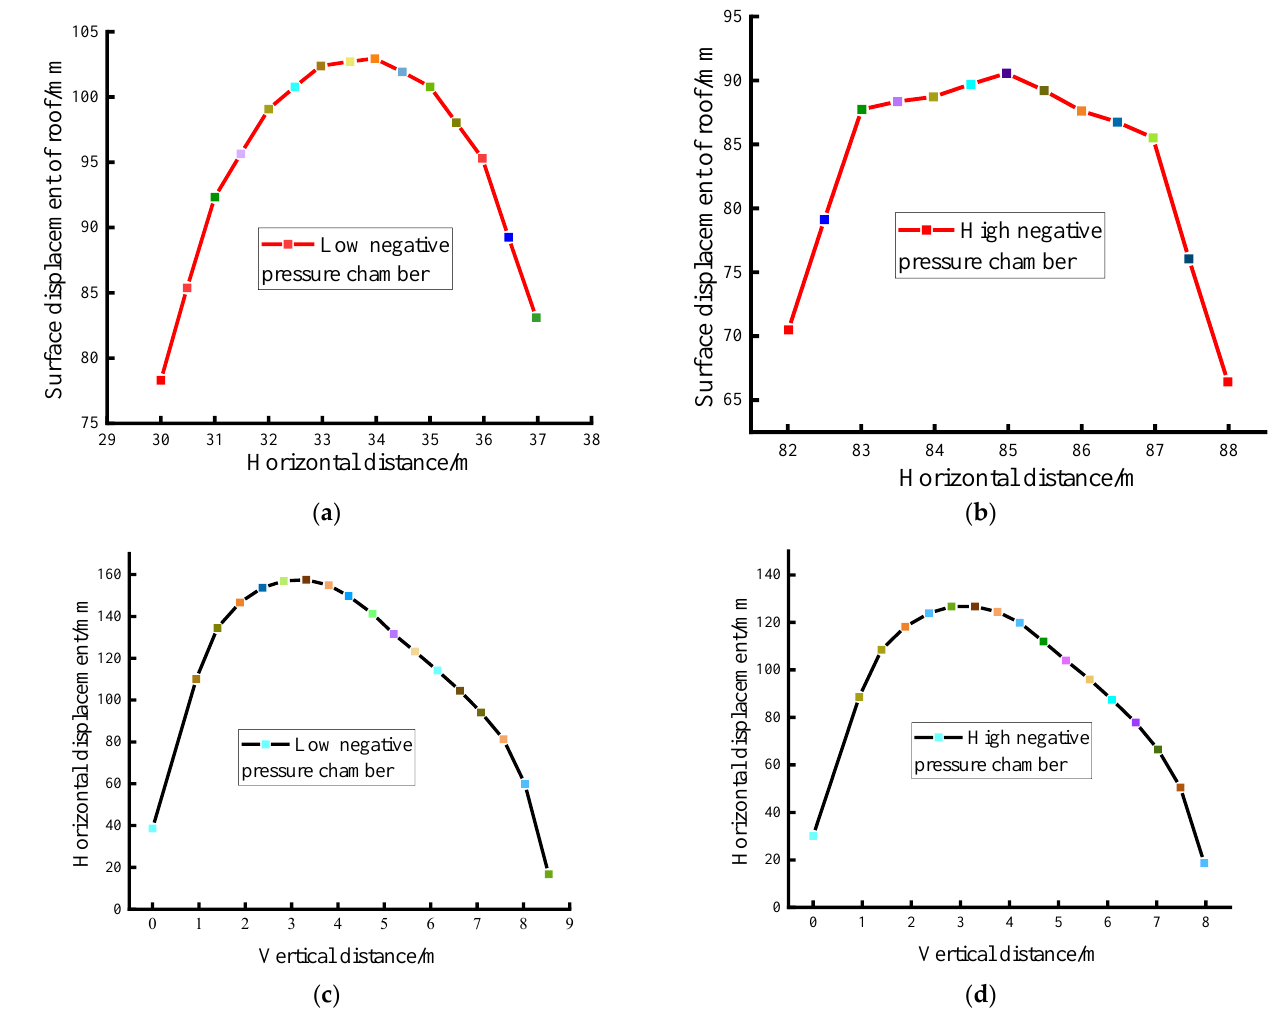
Figure 11. A cavern displacement diagram. ( a ) Roof displacement of a low-negative pressure cavern; ( b ) roof displacement of a high-negative pressure cavern; ( c ) two-sided displacement of a low-negative pressure cavern; and ( d ) two-sided displacement of a high-negative pressure cavern.